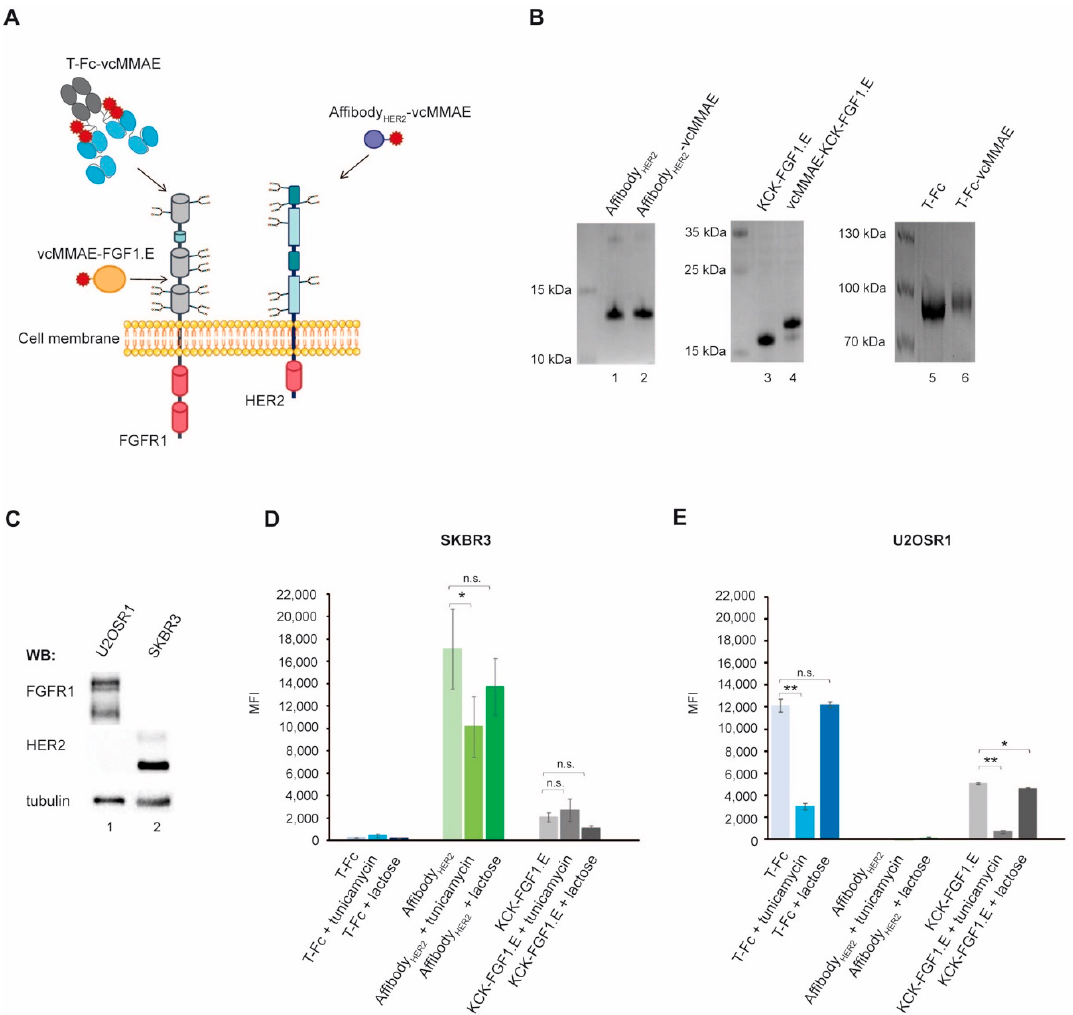
cells. Flow cytometry experiments revealed that treatment of SKBR3 and U2OSR1 cells with tunicamycin significantly inhibited the internalization of all studied targeting mole- cules (Figure 1D,E). At the same time, we observed no internalization of KCK-FGF1.E nor T-Fc into SKBR3 cells and Affibody HER2 into U2OSR1 cells, confirming the high specificity of the targeting molecules employed (Figure 1D,E). These data indicate that cell surface N-glycosylation is essential for effective receptor-mediated, selective internalization of CCs targeting HER2 and FGFR1.